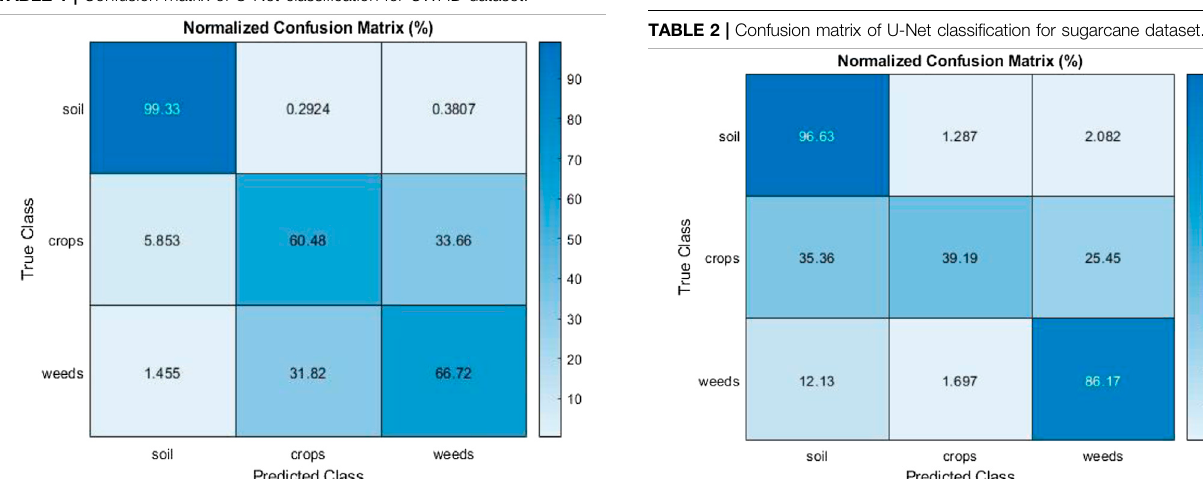
TABLE 1 | Confusion matrix of U-Net classi fi cation for CWFID dataset.